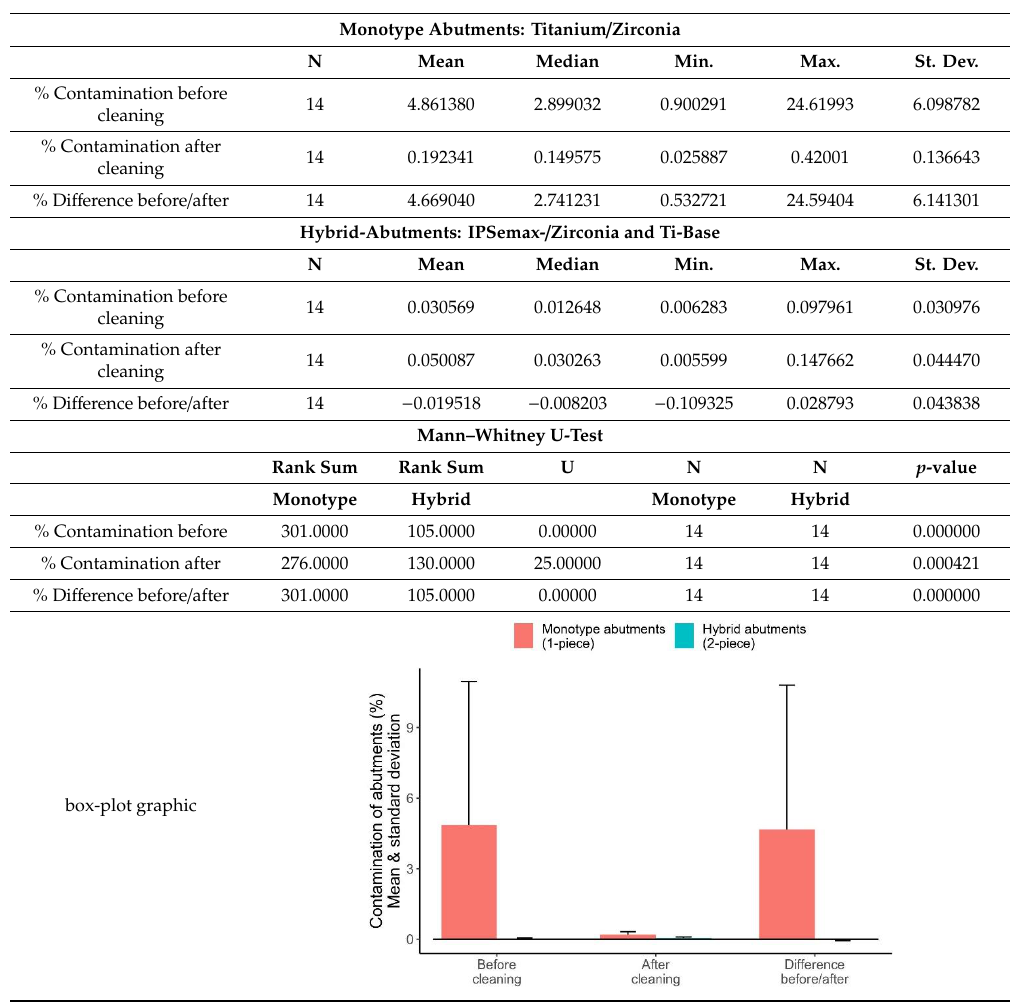
Table 7. Comparison of projected surface contamination between monotype and hybrid abutments before and after cleaning in percent; Mann–Whitney U-Test; box-plot graphic.